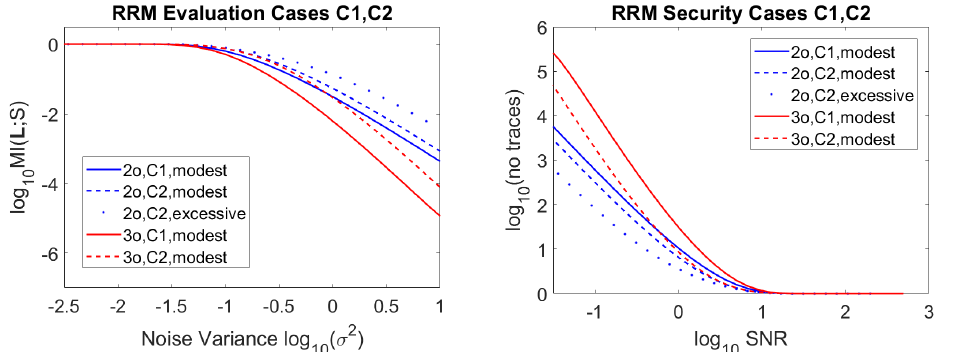
Figure 4: MI evaluation and no. traces bound for 1st and 2nd-order secure RRM schemes with 2 multiplications, assuming naive-tuple (C1 - equivalent to std. masking) and chosen- tuple (C2) adversaries. The evaluation considers gadgets with modest and excessive recycling. Blue lines denote 2nd-order attack (vs. 1st-order RRM) and red lines denote 3rd-order attack (vs. 2nd-order